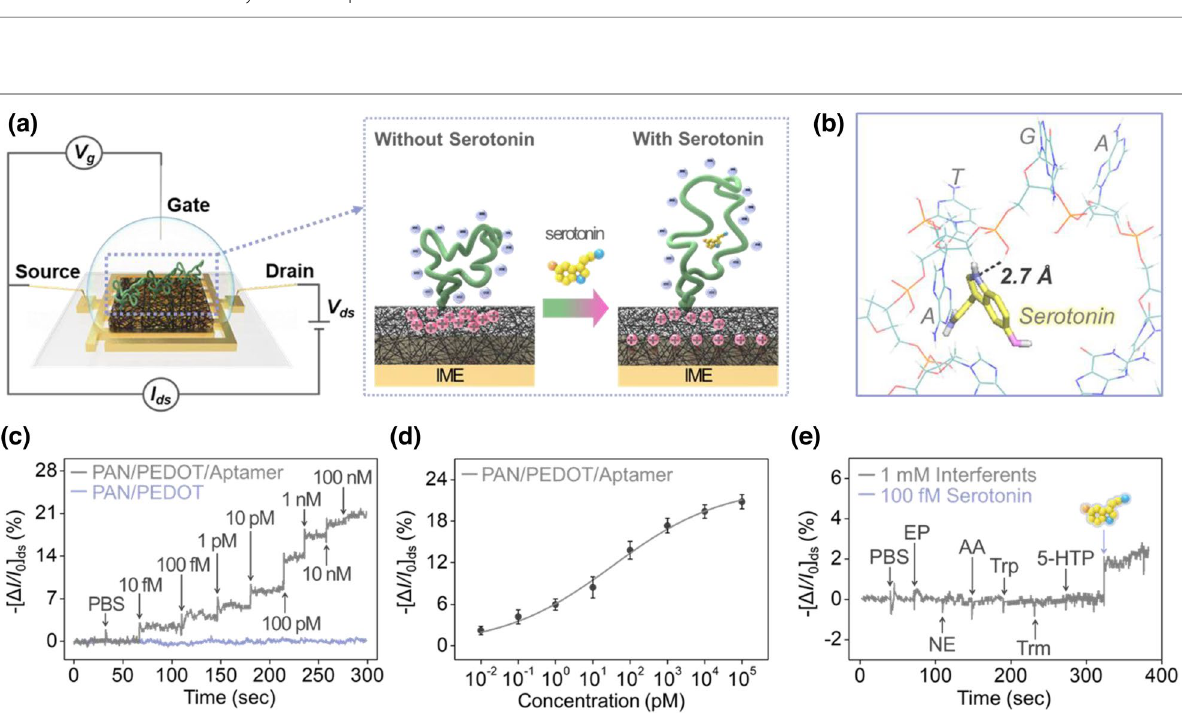
Fig. 3 Electrical measurement of the PEDOT nanohybrids-loaded sensor platform. (a) Schematic illustration showing the device configuration of the PEDOT-based sensor platform (left) and the sensing mechanism between the aptamer and serotonin (right). (b) Biosimulation of the reaction between the serotonin molecule and aptamer. (c) Real-time measurement of serially diluted serotonin concentrations (range of 10 fM to 100 nM) with the bare electrode and aptamer-immobilized PEDOT nanohybrids-loaded electrode. (d) Calibrated response curve of the aptamer-immobilized transistor toward serotonin. (e) Selectivity results with 100 fM serotonin and 1 mM various